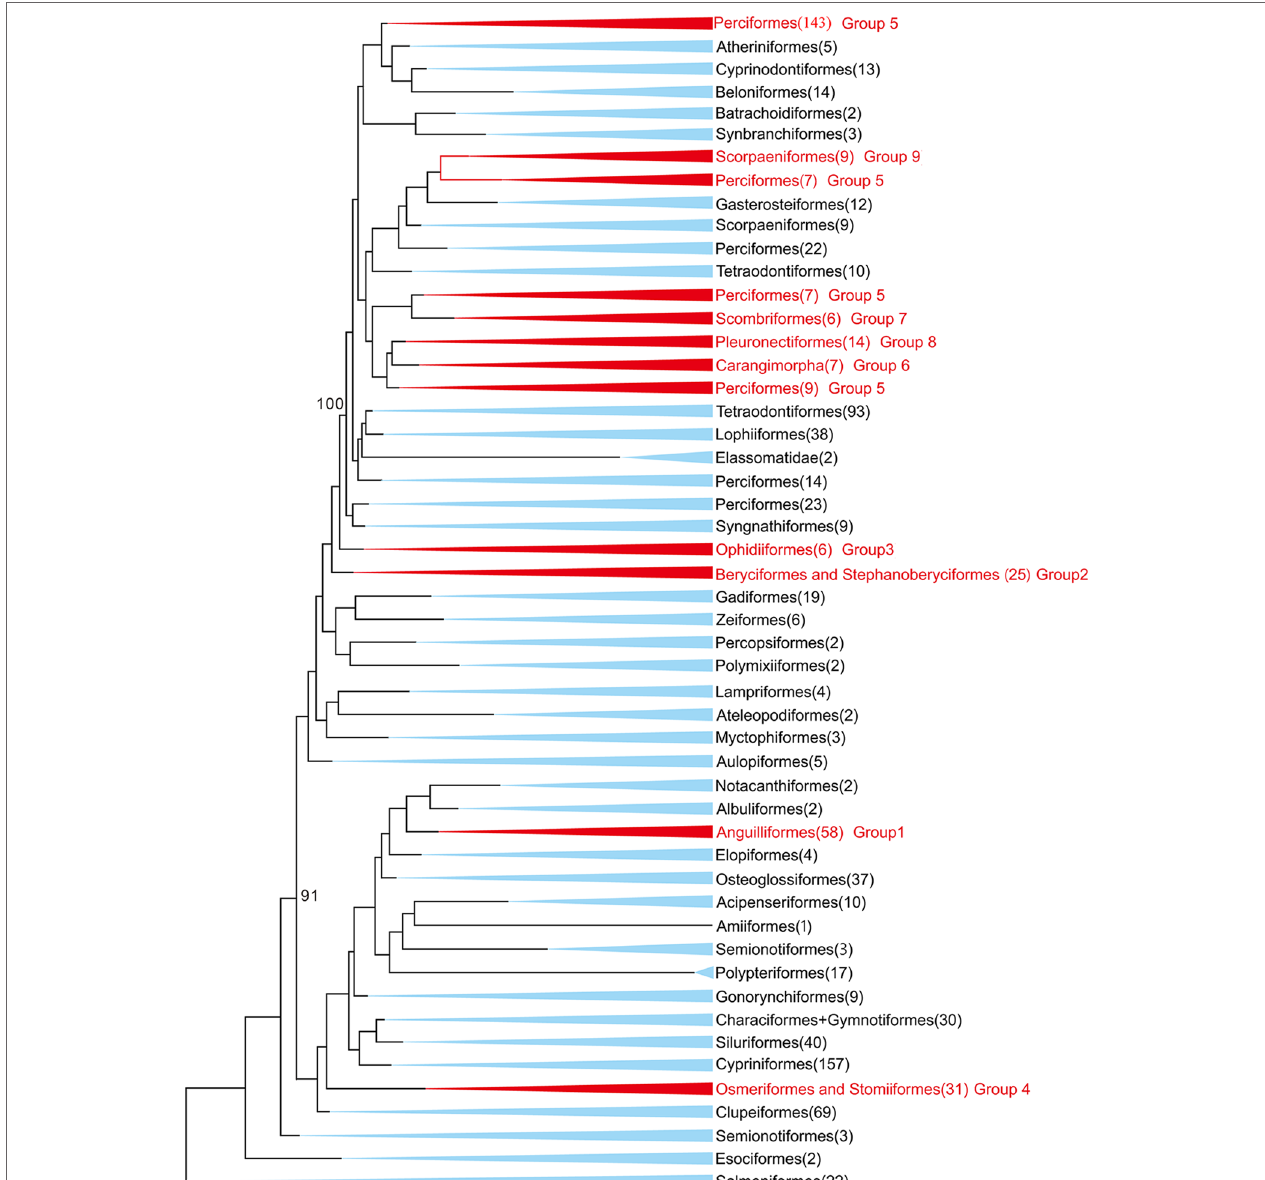
FIGURE 1 | Maximum-likelihood (ML) phylogenetic tree of 1,042 bony fishes. The tree displays 47 orders. The nine groups studied in this study were marked in red. Numbers in the brackets denote available mitochondrial genomes.